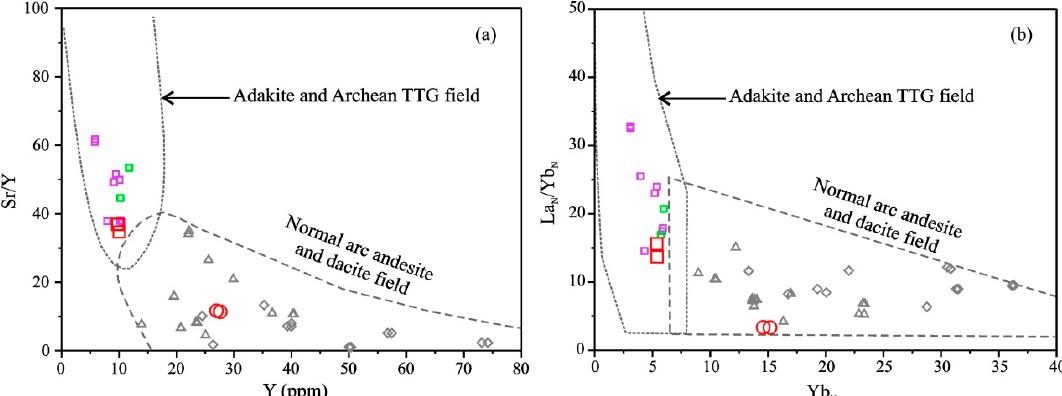
Figure 8. Plots of Sr/Y versus Y ( a ) and La N /Yb N versus Yb N ( b ) for the granodiorites and NEBs from the Xiaozhenzhu Seamount near the Zhongnan Fault in the SCS. Also shown are the data of Mesozoic arc and adakitic granitoids from the SCS [23,24]. The fields of adakite and Archean TTG, and of normal arc andesite and dacite are from [56] and [57], respectively. The symbols are as in Figure 6.